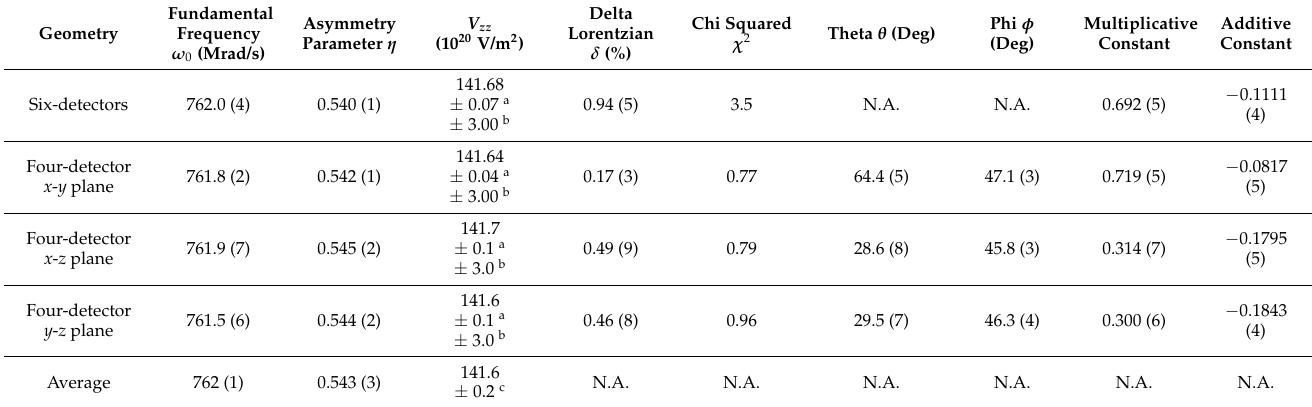
Table 1. Table of fitted hyperfine and experimental parameters for the single γ − γ TDPAC mea- surement of 181 Ta(TiO 2 ) with four possible geometries, as given by the Gfit19 TM program. For the individual values of V zz , the fit uncertainty is separated into (a) the statistical uncertainty caused by our instruments, and (b) the (dominant) systematic uncertainty of the quadrupole moment ( ± 2.1%) as quoted in reference [51]. Note (1) the large χ 2 value of the six-detector measurement and (2) the large multiplicative constant of the four-detector in the x-y plane TDPAC measurement vis- à -vis the two other four-detector TDPAC measurements. The averaged values of ω 0 , η , and V zz from the four different geometries were calculated, with (in the case of V zz , (c)) the uncertainty assigned the square root of the sum of squares of their statistical uncertainty (in the case of V zz ,